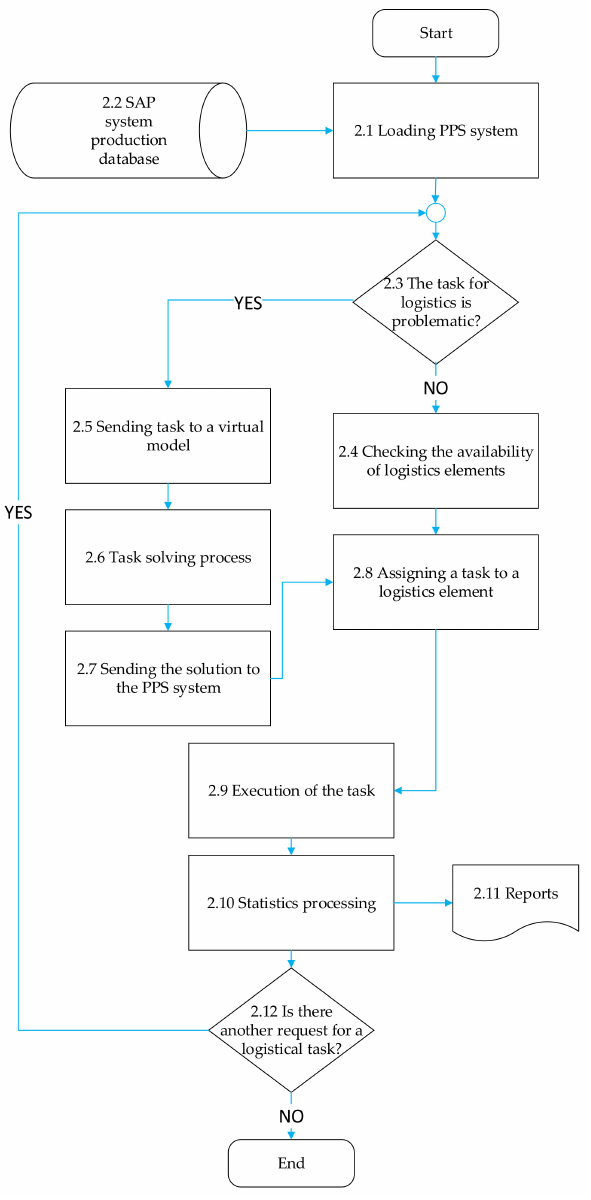
Figure 3. The production planning and control